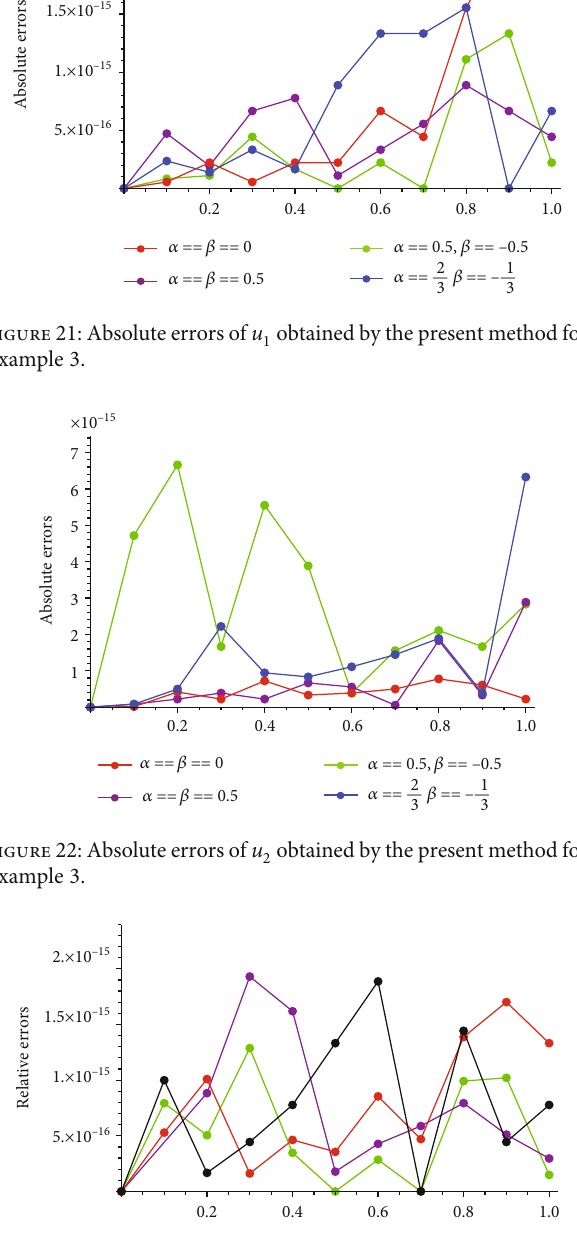
Figure 23: Relative errors of u 1 obtained by the present method with α = β = 0 (red), α = β = 0 : 5 (purple), α = 0 : 5, β = − 0 : 5 (green), and α = 2/3, β = − 1/3 (black) for Example